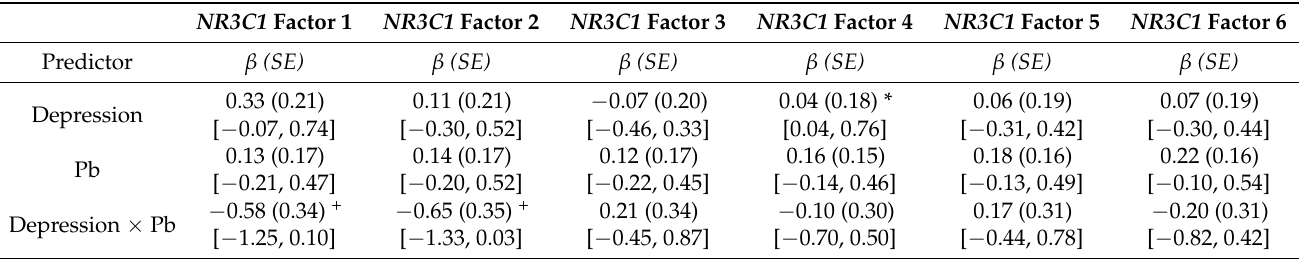
Table 2. Multivariable linear regression models testing the joint contribution of depression and Pb exposure during pregnancy on NR3C1 DNA methylation factor scores.